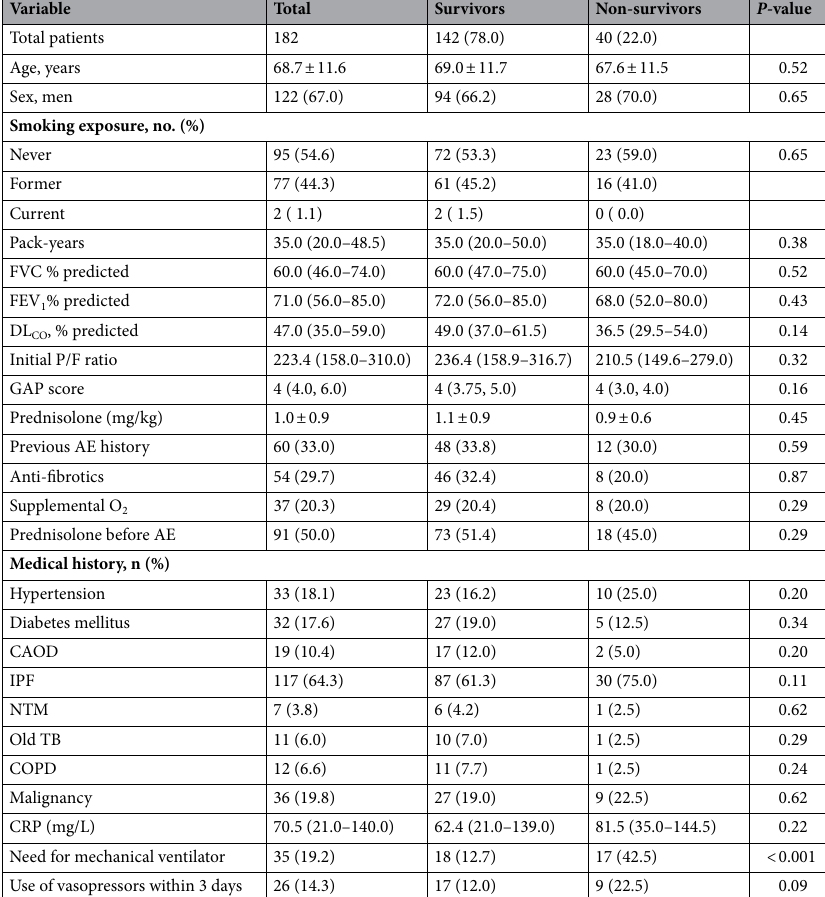
Table 4. Comparison of characteristics between survivors and non-survivors in patients with acute exacerbation of ILD. Data are presented as mean and standard deviation, median and interquartile range, or frequency (%). ILD interstitial lung disease, FVC forced vital capacity, FEV 1 forced expiratory volume in 1 s, DLco diffusing capacity of carbon monoxide, P/F ratio partial pressure of oxygen in arterial blood (PaO 2 )/fraction of inspired oxygen (FiO 2 ) ratio, GAP score system gender (G), age (A), physiology (P), AE acute exacerbation, CAOD coronary artery occlusive disease, IPF idiopathic pulmonary fibrosis, NTM non- tuberculous mycobacterium, COPD chronic obstructive lung disease, Old TB previous tuberculosis, CRP C-reactive protein.